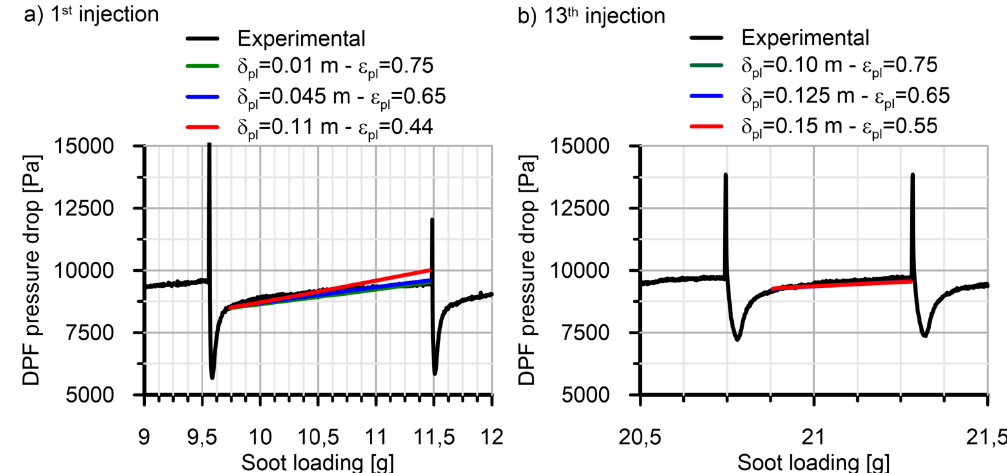
Figure 11. Influence of the soot mass distribution onset and the particulate layer porosity on the rate of increase of the pressure drop after water injection events in DPF